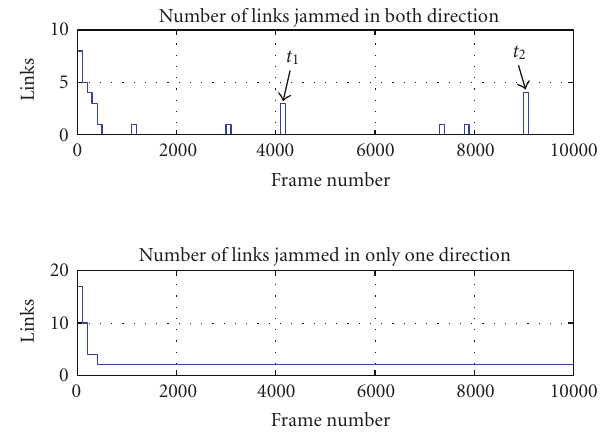
Figure 17: Averaged network’s censorship ratio on 100 blocks, for implemented Steiner